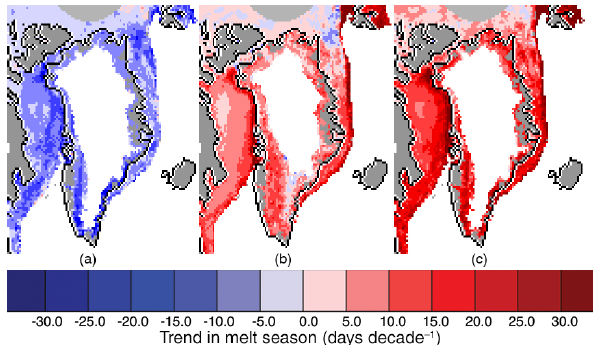
Figure 6. Trends in melt onset ( a ), freeze-up (b) and total melt sea- son length (c) for sea ice and Greenland from 1979 to 2015. Trends are computed using linear least squares and evaluated at the 95% confidence level using Student’s t